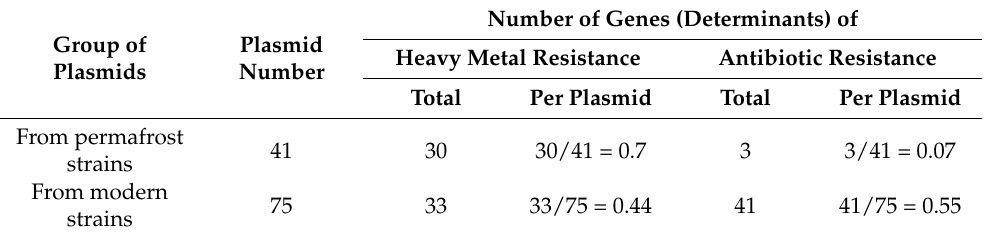
Table 2. The number of plasmid-encoded heavy metal and antibiotic-resistant genes (operons) in permafrost and modern A. lwoffii